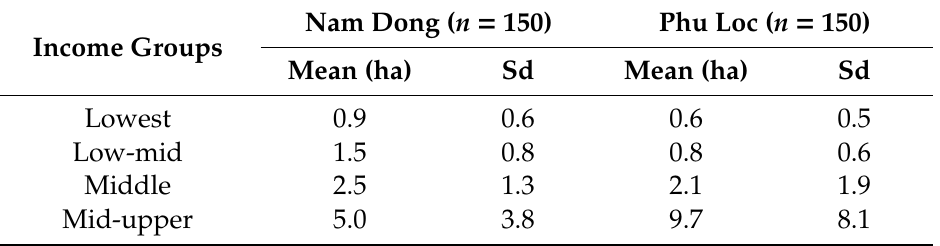
Table 4. Acacia hybrid plantation holdings by income groups in Nam Dong and Phu Loc